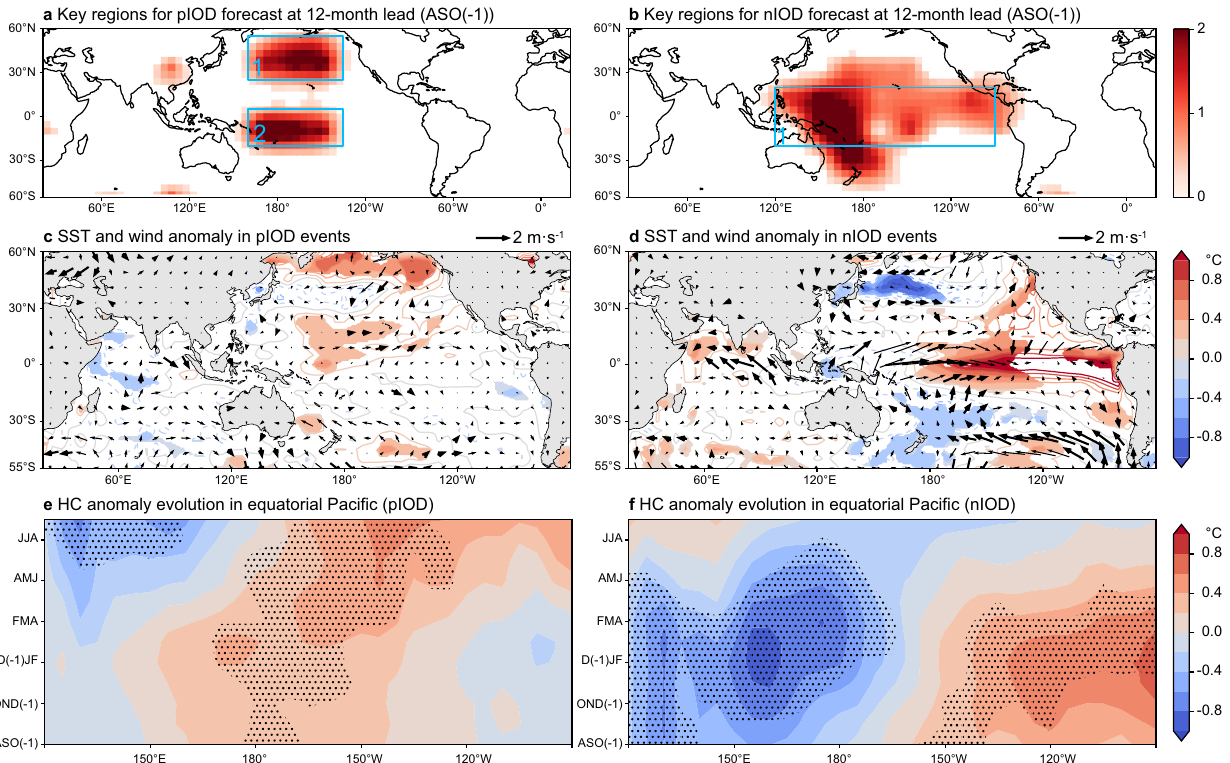
Fig. 4 | The physical interpretation of the Indian Ocean Dipole (IOD) predic- tions at 12-month lead. a Spatial attention map of the fi ve strong positive IOD events (pIOD) during 1983 – 2019 based on the 12-month lead predictions, i.e., initiatedfromAugust-September-Octoberofthepreviousyear(ASO( − 1)).Onlythe values statistically signi fi cant at 10% level are displayed. The heatmap values are split into different key regions (i.e., blue boxes) according to known physics. (c) Composite map of the observed sea surface temperature (SST; shading and